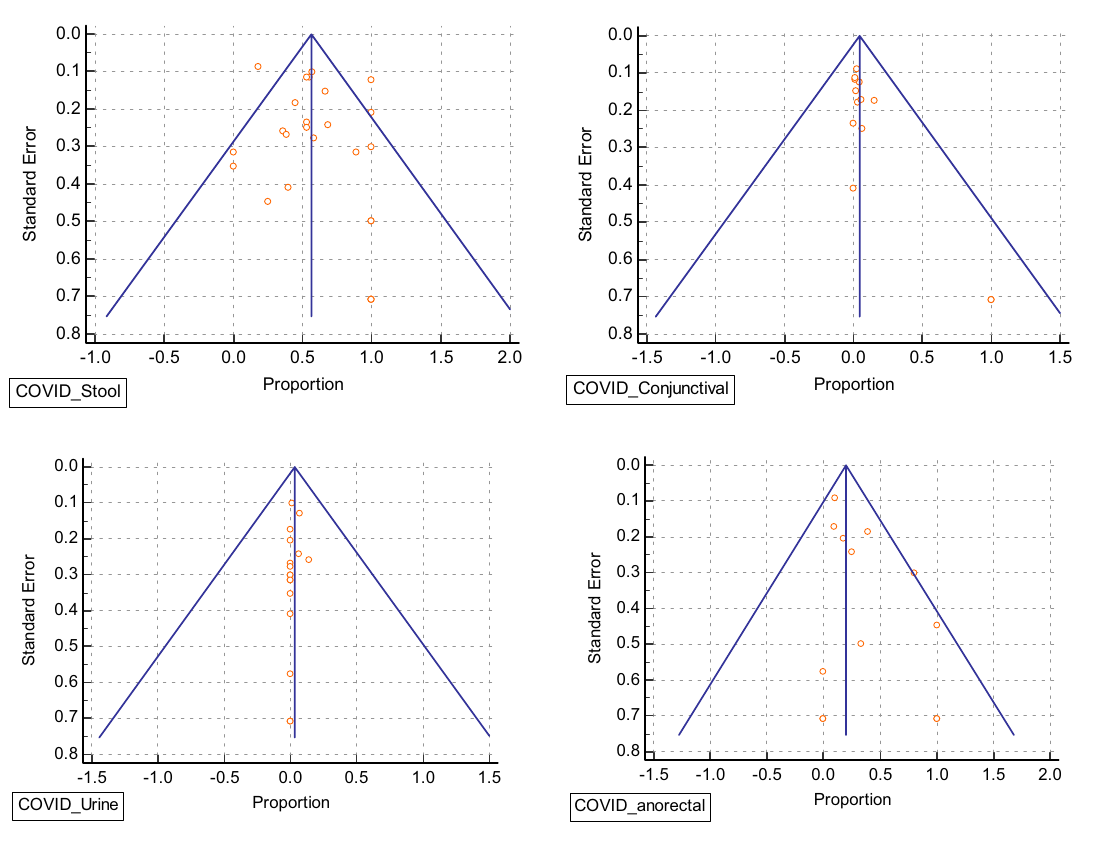
Figure 5. Funnel plot based on egger bias.